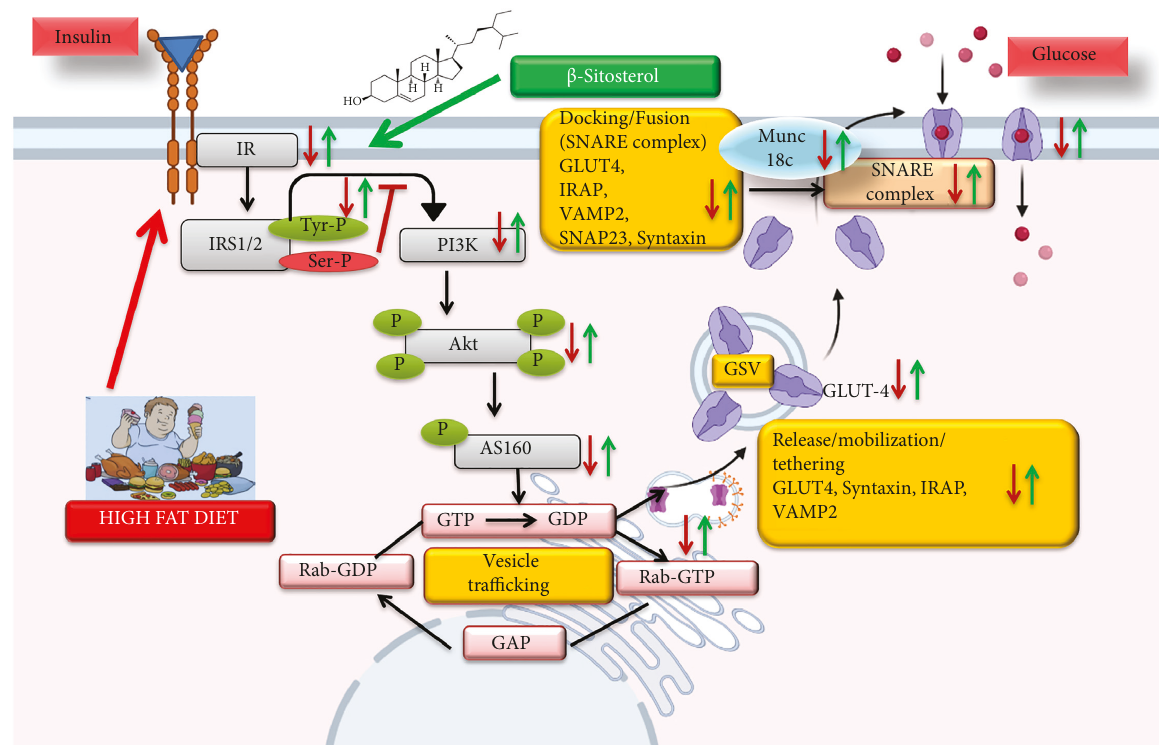
Figure 12: Schematic illustration of β -sitosterol’s role in glucose uptake in the gastrocnemius muscle in HFD and sucrose-induced T2DM. The detrimental effects of the HFD and sucrose-induced diabetes are shown in red, whereas the potential benefits of the β -sitosterol-treated HFD and sucrose-induced T2DM are shown in